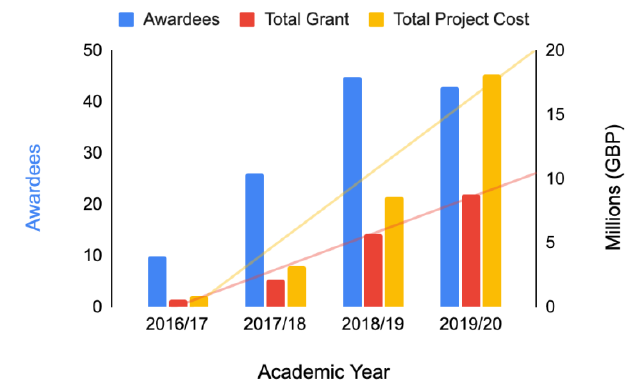
Figure 10: Innovate UK total blockchain-related project funding, costs and